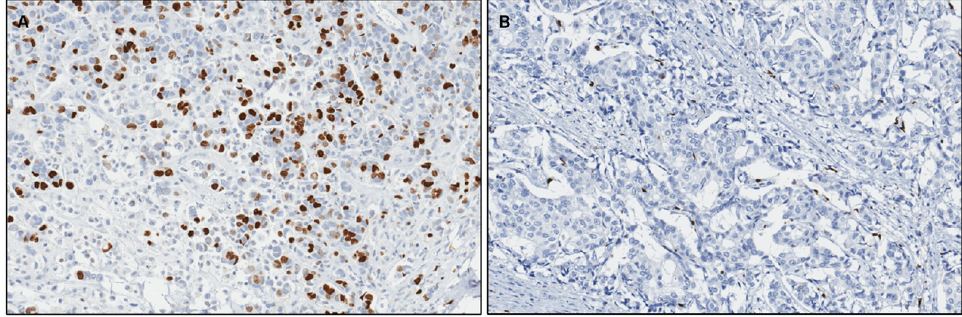
Example tiled region from a low-risk